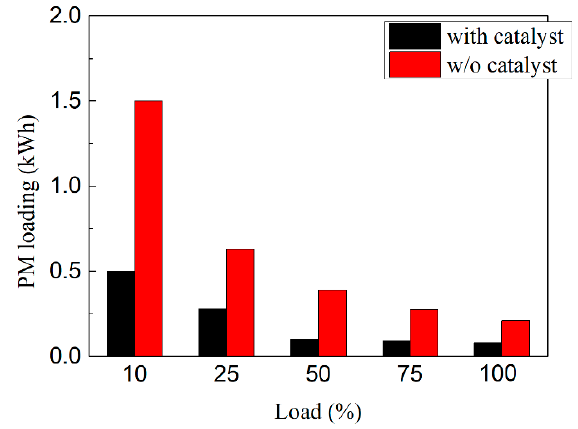
Figure 10. PM loading with and without catalyst at different engine loads.